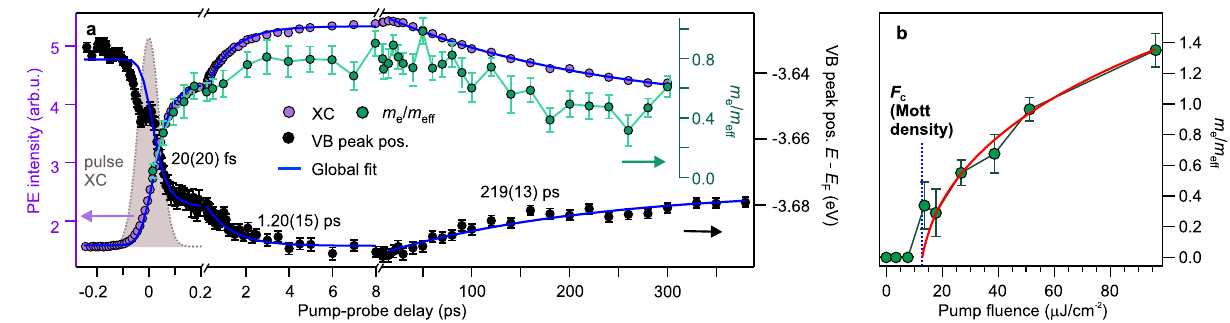
Fig. 2 Dynamics and fl uence dependence of the surface metallization. a Purple: PE intensity below E F (proportional to the surface electron density). The energy-integration window is indicated by the purple box (XC) in Fig. 1d. Green: Curvature of the metallic band (inverse effective mass m eff , determination see Supplementary Fig. 1). Black: VB peak position (determination see Fig. 3). The blue line is a global fi t (see Methods). Gray area: Instrument response function. b Fluence-dependent evolution of the band curvature. Red solid line: Fit with the critical form, Eq. (1). Error bars in a and b respresent standard